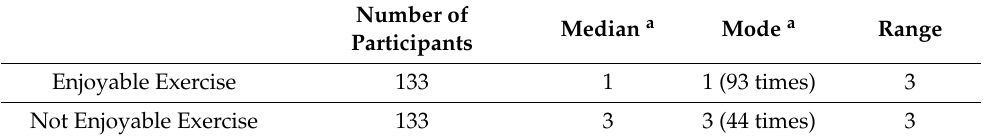
Table 2. Impact of perceived enjoyment on cognitive exercise self-efficacy